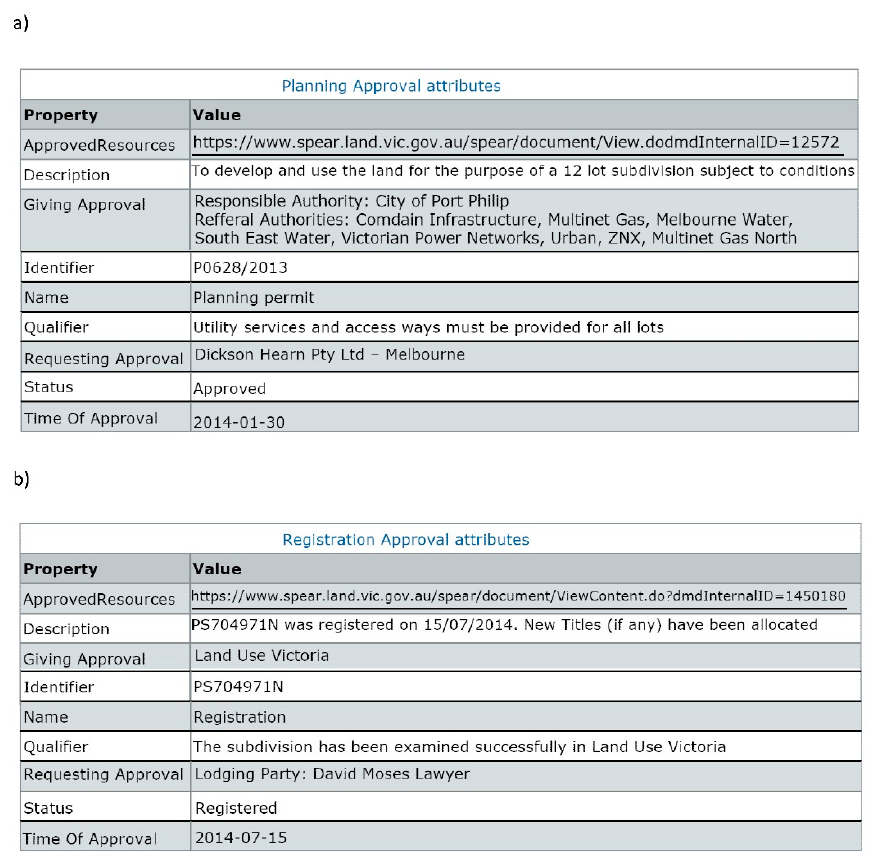
Figure 13. Snapshot of approval attributes shown in a BIM viewing tool ( a ) Planning approval attributes ( b ) Registration approval attributes.